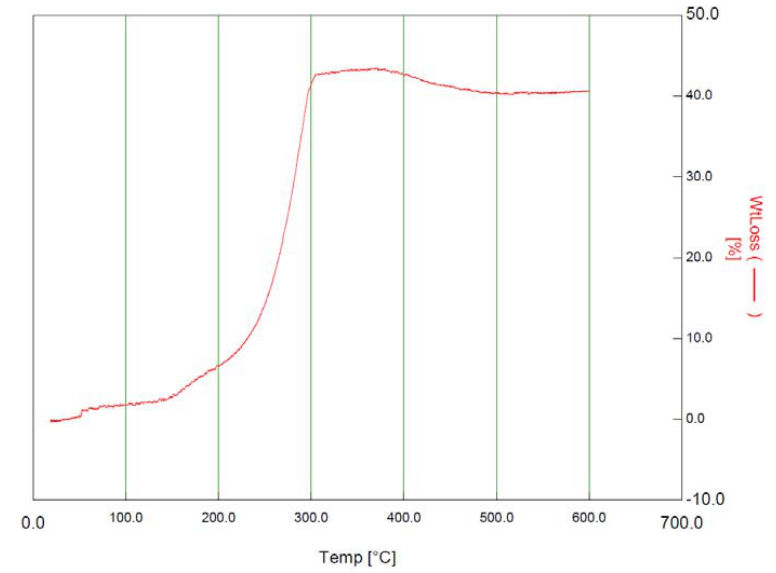
Fig. 5 Fig. 5. Thermogravimetric analysis (TGA) of the adsorbent.